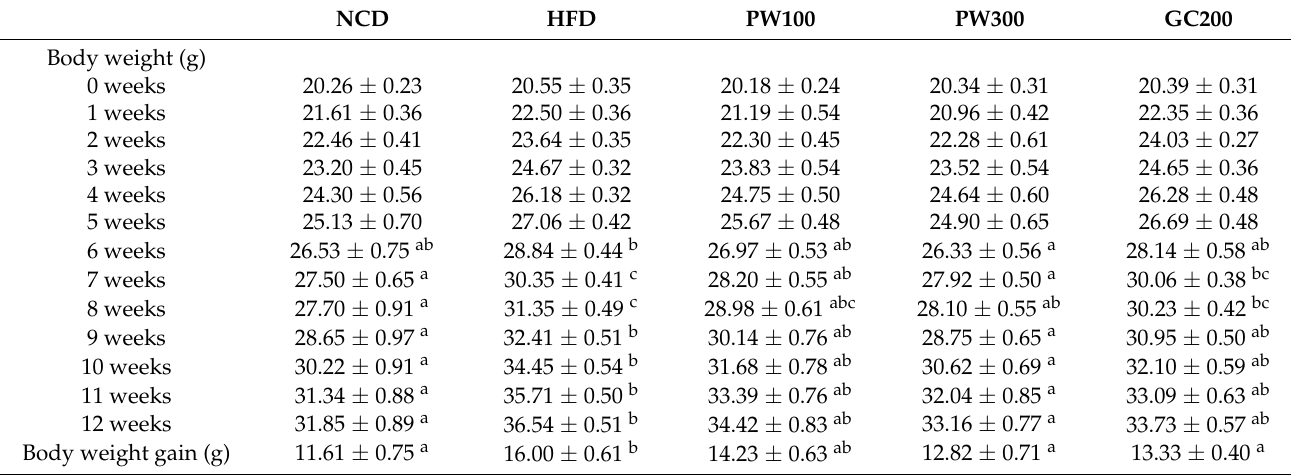
Table 1. Effects of Polygonum multiflorum Thunb. hot water extract on body weight in HFD diet-induced obese